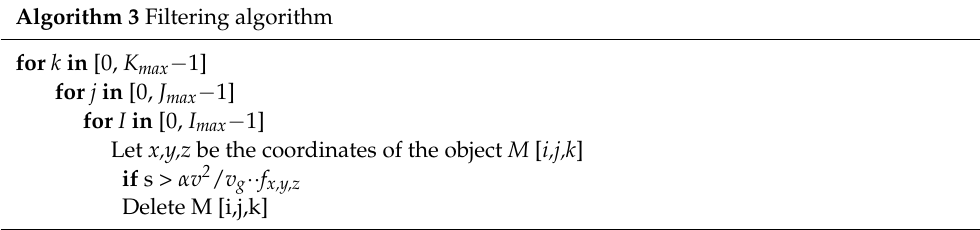
Algorithm 3 Filtering